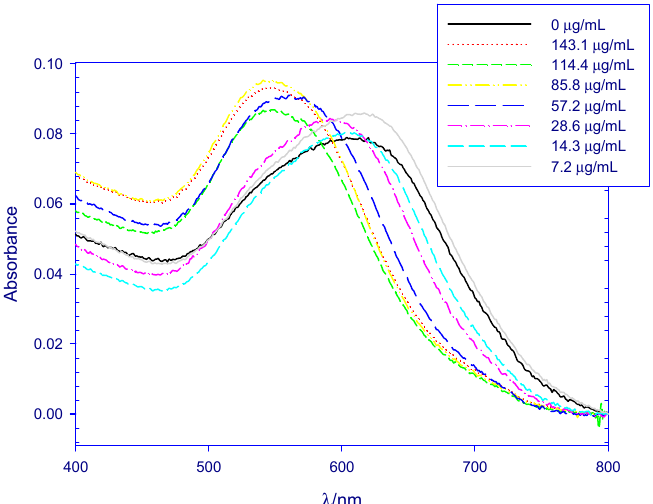
Figure 6. Normalized absorbance spectra for different concentrations of urinary lysozyme. Series correspond to sample F.